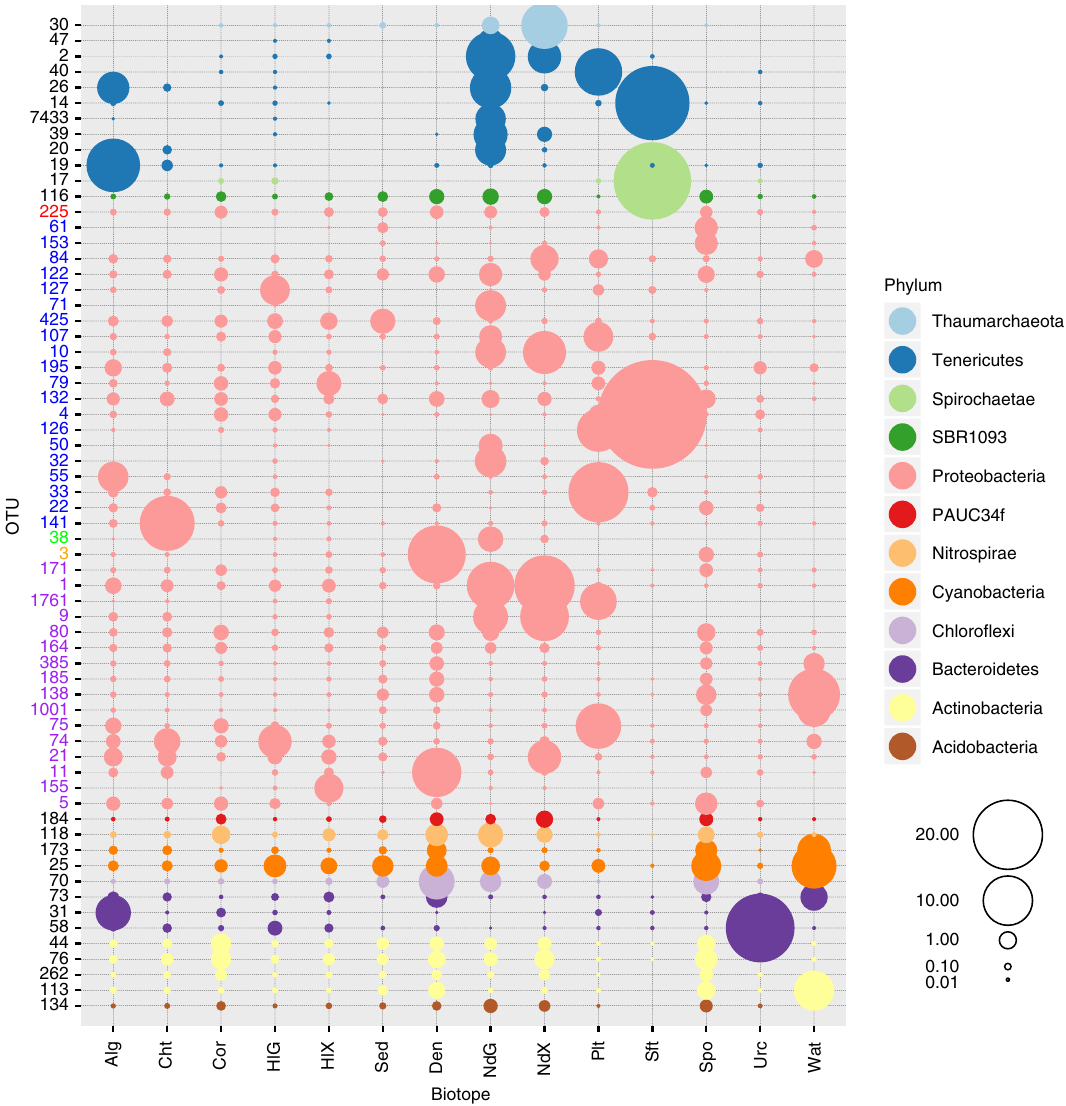
Fig. 4 Relative abundance of signi fi cantly discriminating OTUs ( P < 0.001) identi fi ed using Simper. Symbols are colour-coded according to prokaryote phylum. Codes on the x -axis represent algae (Alg), chitons (Cht), stony corals (Cor), sea cucumber gut (HlG), sea cucumber mantle (HlX), sediment (Sed), sponge denizens (Den), nudibranch gut (NdG), nudibranch mantle (NdX), fl atworms (Plt), soft corals (Sft), sponges (Spo), sea urchins (Urc) and seawater (Wat). The circle size of the OTU is proportional to the mean percentage of sequences per biotope as indicated by the symbol legend in the bottom right corner of the fi gure. The y -axis shows the OTU id number. The y -axis numbers have been colour coded for the proteobacterial OTUs to identify class assignment; red: JTB23, blue: Gammaproteobacteria, green: Epsilonproteobacteria, orange: Betaproteobacteria and purple: Alphaproteobacteria. Source data are provided as a Source Data fi